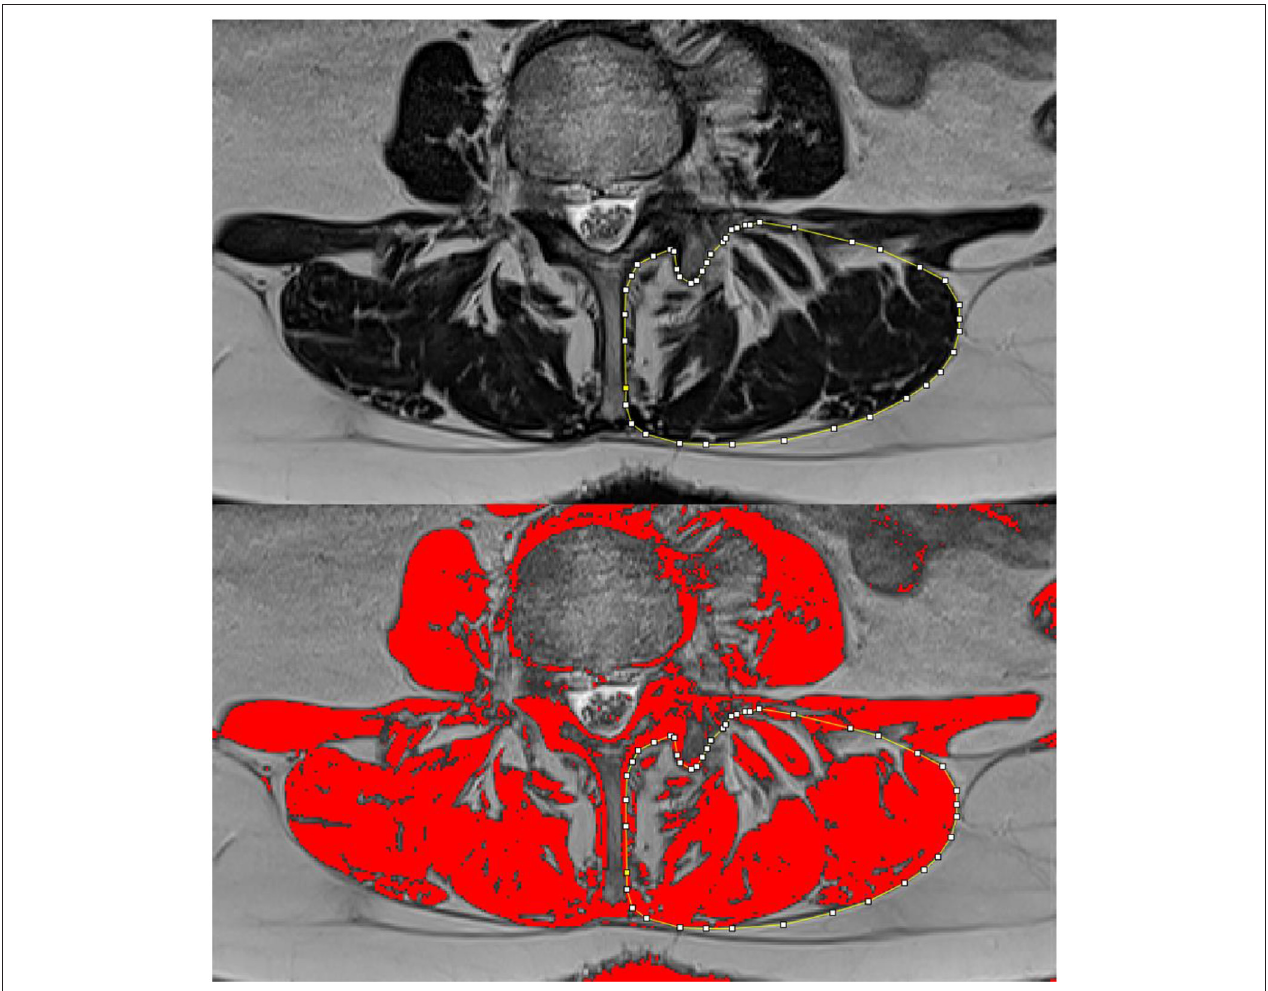
FIGURE 2 | Using the ImageJ analysis software, the left paraspinal muscles are contoured and the cross-sectional area is measured (top); after thresholding, the lean muscle is represented in red, and its area (LeanCSA) is measured